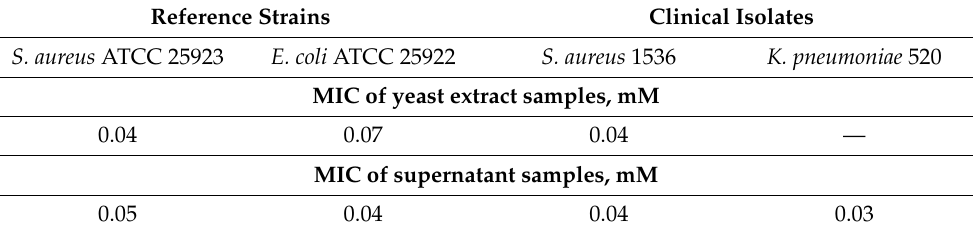
Table 3. Minimum inhibitory concentration (MIC) of samples by crystal violet